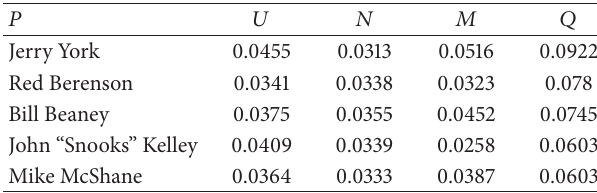
Table 14: Varies data after normalization (hockey).